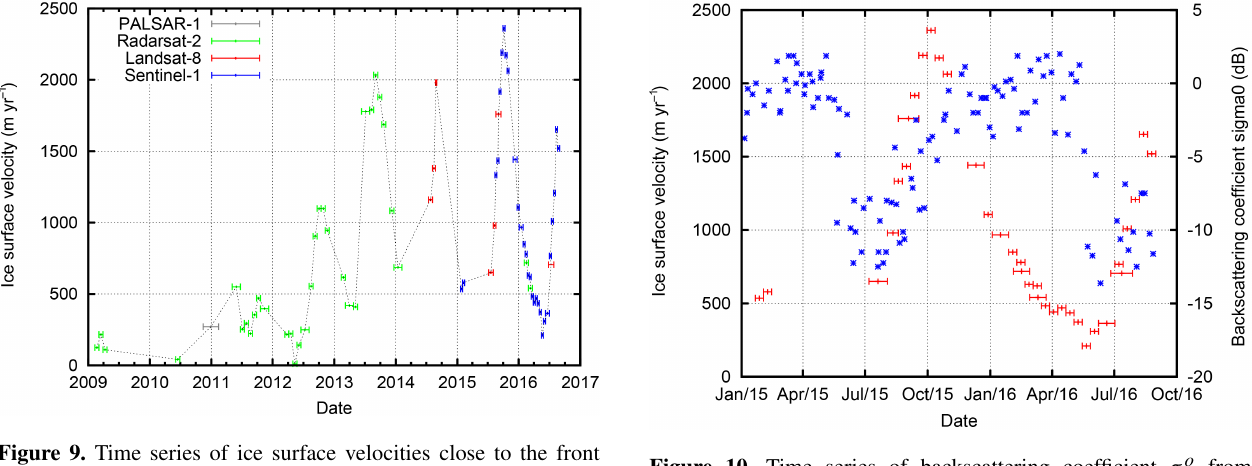
Figure 10. Time series of backscattering coefficient σ o from Sentinel-1 EWS data (blue stars) along with the time se- ries of ice surface velocities from Sentinel-1 IWS data (red crosses) close to the front of the southern lobe of Stonebreen (716080 ◦ E/8646230 ◦ N). For position see Fig.